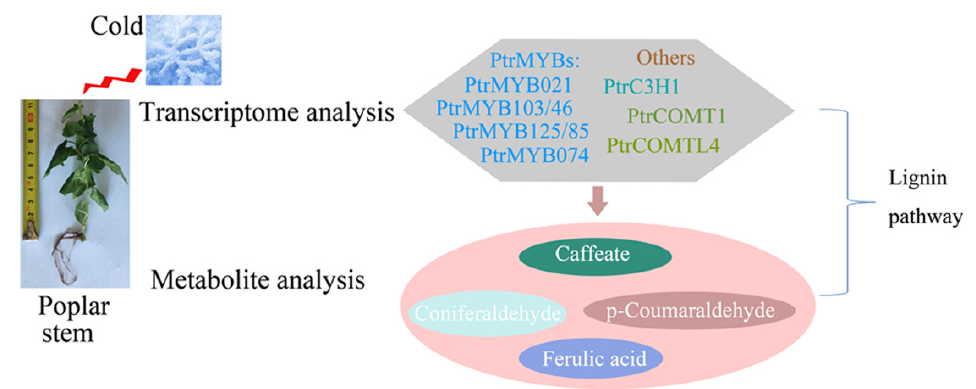
Figure 7. Regulatory mechanism that explains how the regulators regulate the pathway between low temperature and lignin. Cold temperatures resulted in the changes in content of lignin in poplar. A transcriptomic analysis indicated that some vital transcription factors, such as PtrMYBs, other transcription factors related to lignin, and structural genes related to lignin, such as PtrC3 ′ H1 , PtrCOMTL4 , PtrCOMT1 and others, were induced by chilling. PtrC3 ′ H1 could be a possible factor that leads to a decrease in the content of caffeate, while PtrCOMTL4 and PtrCOMT1 may reduce the amounts of coniferaldehyde, caffeate, ferulic acid, coniferaldehyde, p- coumaraldehyde represents different lignin precursors.